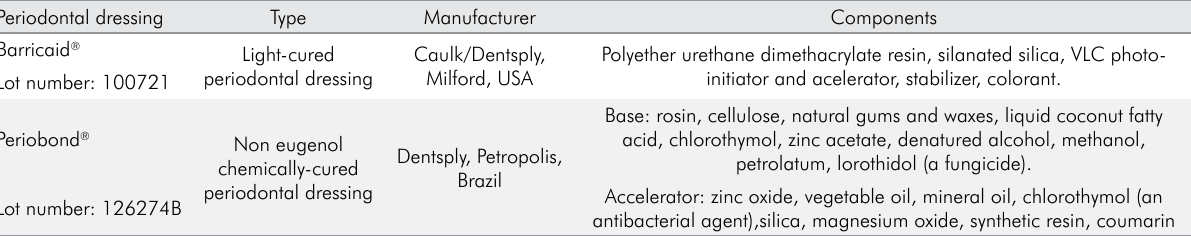
Table 1. Materials used as control and their specifications. Periodontal